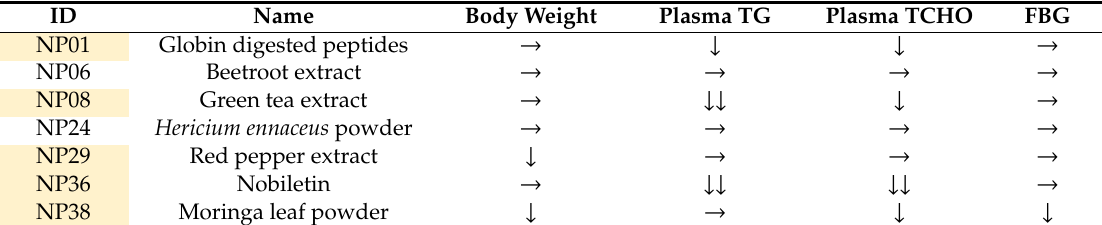
Figure 3. NP administration in adult diet-induced obese (DIO) zebrafish. ( a ) Experimental design for DIO-zebrafish experiment. ( b ) Body weight increases in DIO-zebrafish with or without NPs. ( c – e ) Plasma triglycerides ( c ), total cholesterol ( d ), and fasting blood glucose ( e ) at the end of the experiment. Values presented are means. Error bars indicate SD. n = 5–10, * p < 0.05, ** p < 0.01 vs. control, one-way analysis of variance (ANOVA) with Bonferroni–Dunn multiple comparison. Table 1. Diet-induced obese (DIO)-zebrafish results for natural products (NPs) from the zebrafish obesogenic test